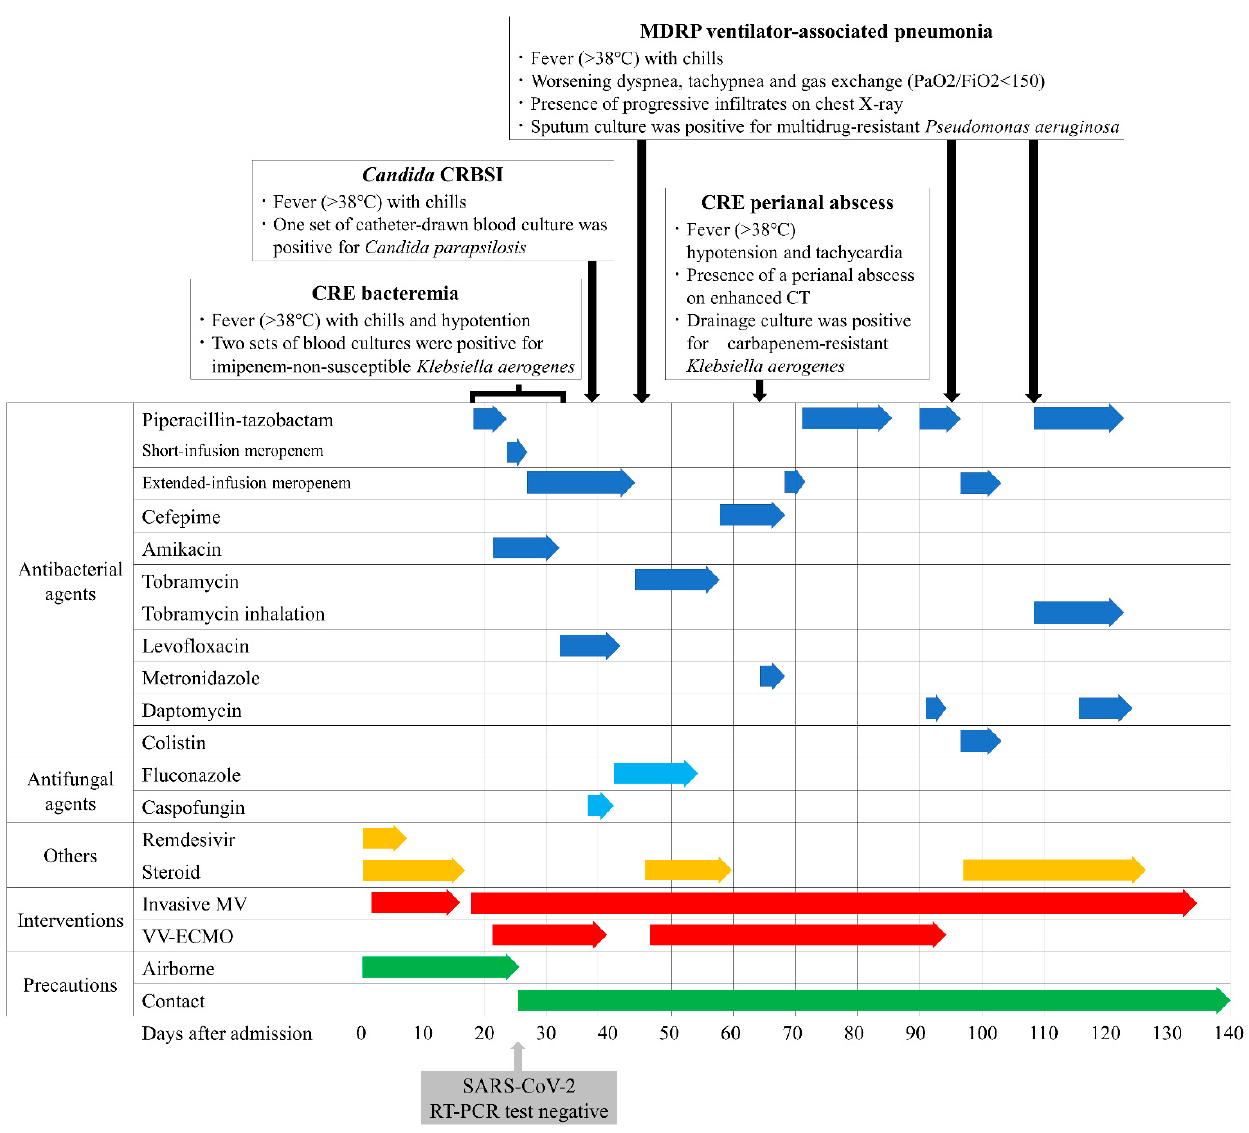
Figure 1. Clinical course and treatment of the present case: The patient had acquired multiple secondary infections requiring long-term broad-spectrum antibiotic use. Centers for Disease Control and Prevention criteria (https://www.cdc.gov/hai/index.html, accessed on 30 November 2021) for diagnosis of catheter-related bloodstream infection and ventilator-associated pneumonia were met. Abbreviations: CRBSI, catheter-related bloodstream infection; CRE, carbapenem-resistant Enterobacteriaceae ; MDRP, multidrug-resistant Pseudomonas aeruginosa ; CT, computed tomography; MV, mechanical ventilation; VV-ECMO, venovenous extracorporeal membrane oxygenation; RT-PCR, reverse transcription polymerase chain reaction.